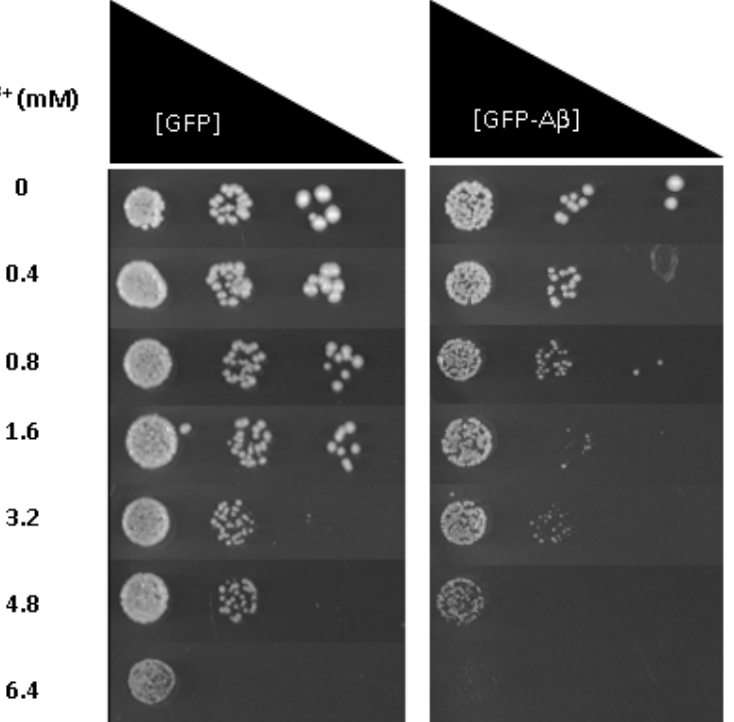
Figure 3. Growth of S. cerevisiae BY4743 [p416GPD.GFP] and BY4743 [p416GPD.GFPA β ] transfor- mants on low-pH and low-phosphate (LPP) medium containing varying concentrations of Al 3+ incubated at 30 ◦ C for 7 days. Analysis of growth inhibition was performed in triplicate rows (transformant strains) and compared. The difference in growth inhibition between the two transformants provides another line of evidence that the combination of A β 42 and Al 3+ has a synergistic toxicity towards cells, with Al 3+ having a dose-dependent toxicity.